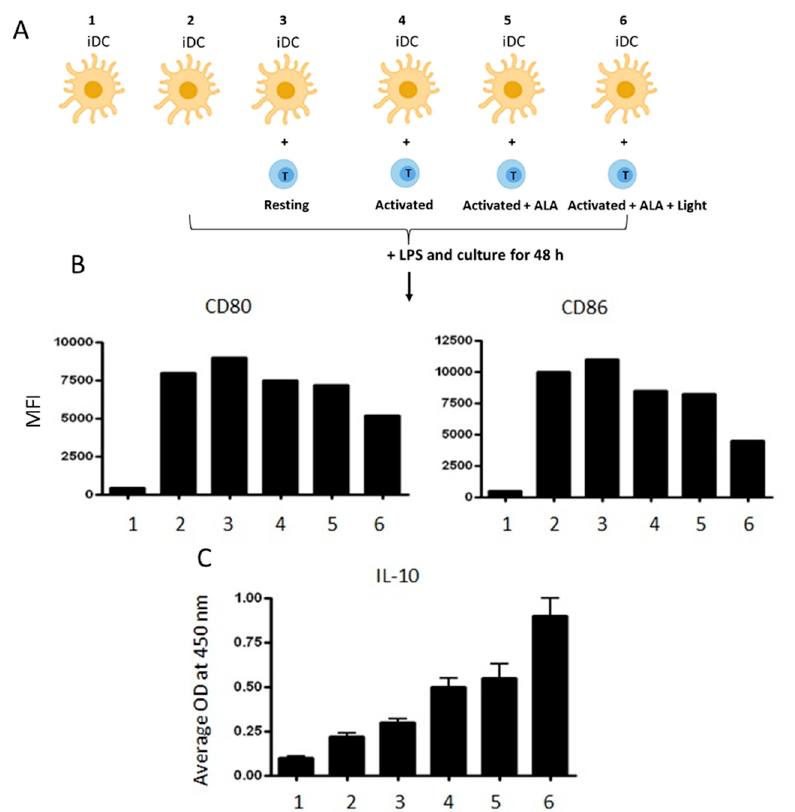
Figure 9. ALA-PDT treated T cells induce tolerogenic DCs. ( A ) monocyte-derived immature DCs (iDC) were co-cultured with autologous ALA-PDT damaged CD4 + T cells and then stimulated with LPS for 48 h as illustrated; ( B ) a representative example of expression of the co-stimulatory molecules CD80 and CD86 analyzed by flow cytometry; ( C ) IL-10 content in the culture supernatants measured by ELISA. The data is a representative of three independent experiments.